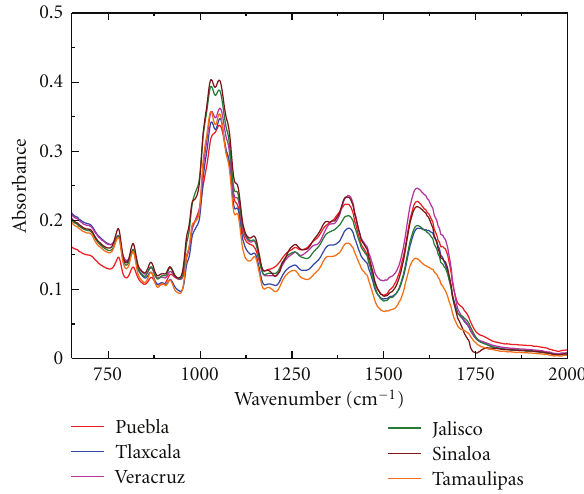
Figure 1: FTIR spectra of phenolic compounds in chilli samples.